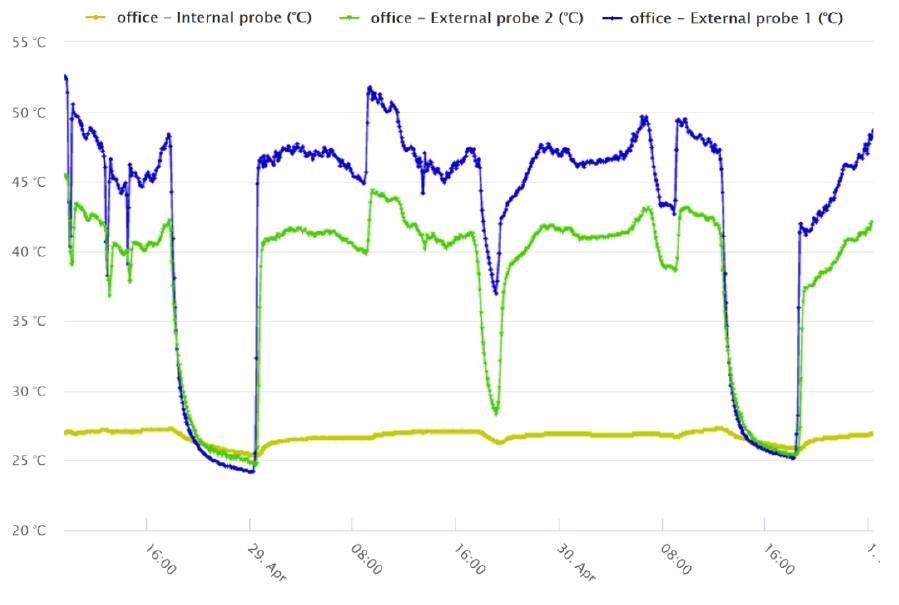
Figure 10. Inlet and outlet temperature from the radiator.